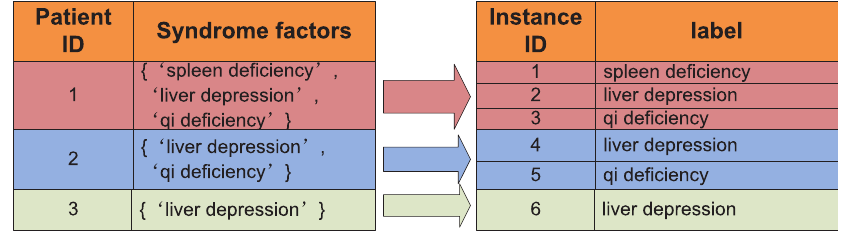
Figure 2. An illustrative example of the PT5 method.